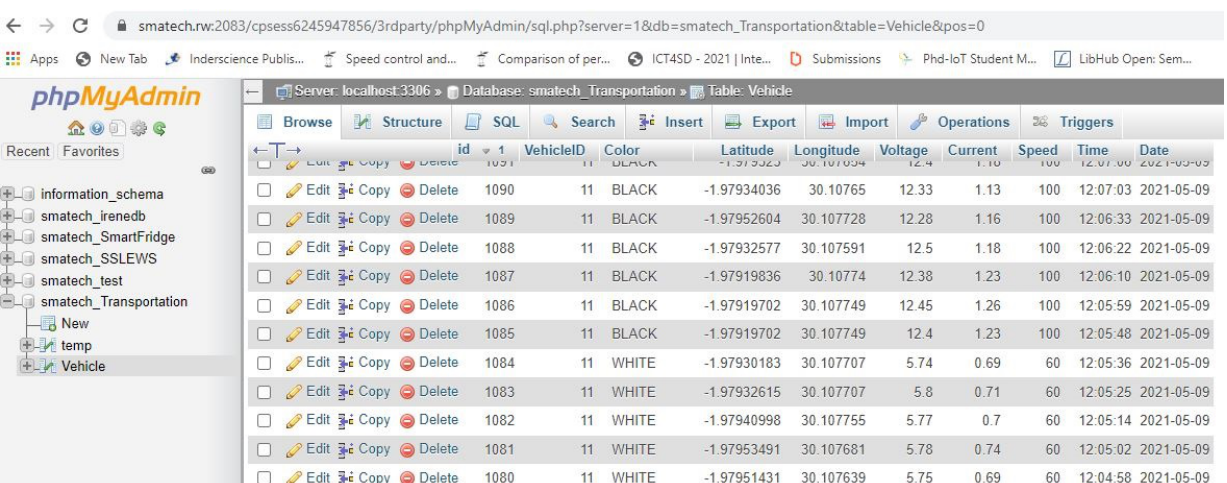
Figure 8. Data presentation in the